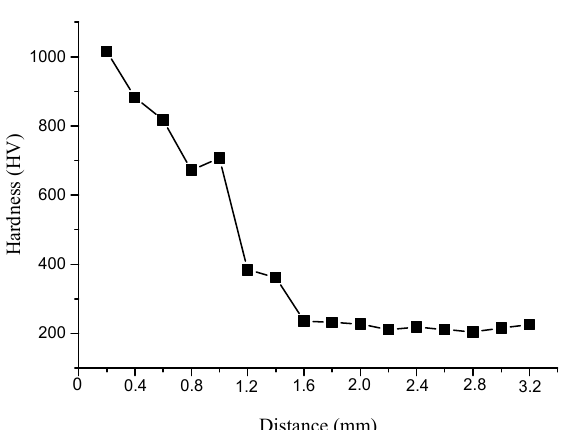
Figure 4. The cross-sectional hardness of the coating as a function with the distance to the top surface of the coating.